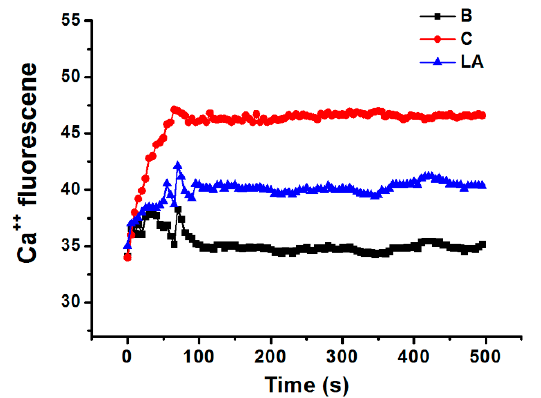
Figure 5. Effect of LA on the level of intracellular calcium in HMC-1 cells. HMC-1 cells were pretreated with LA for 20 min and then stimulated with PMA plus A23187. B, PBS-treated cells; C, PBS-treated, and then PMA plus A23187-stimulated cells.